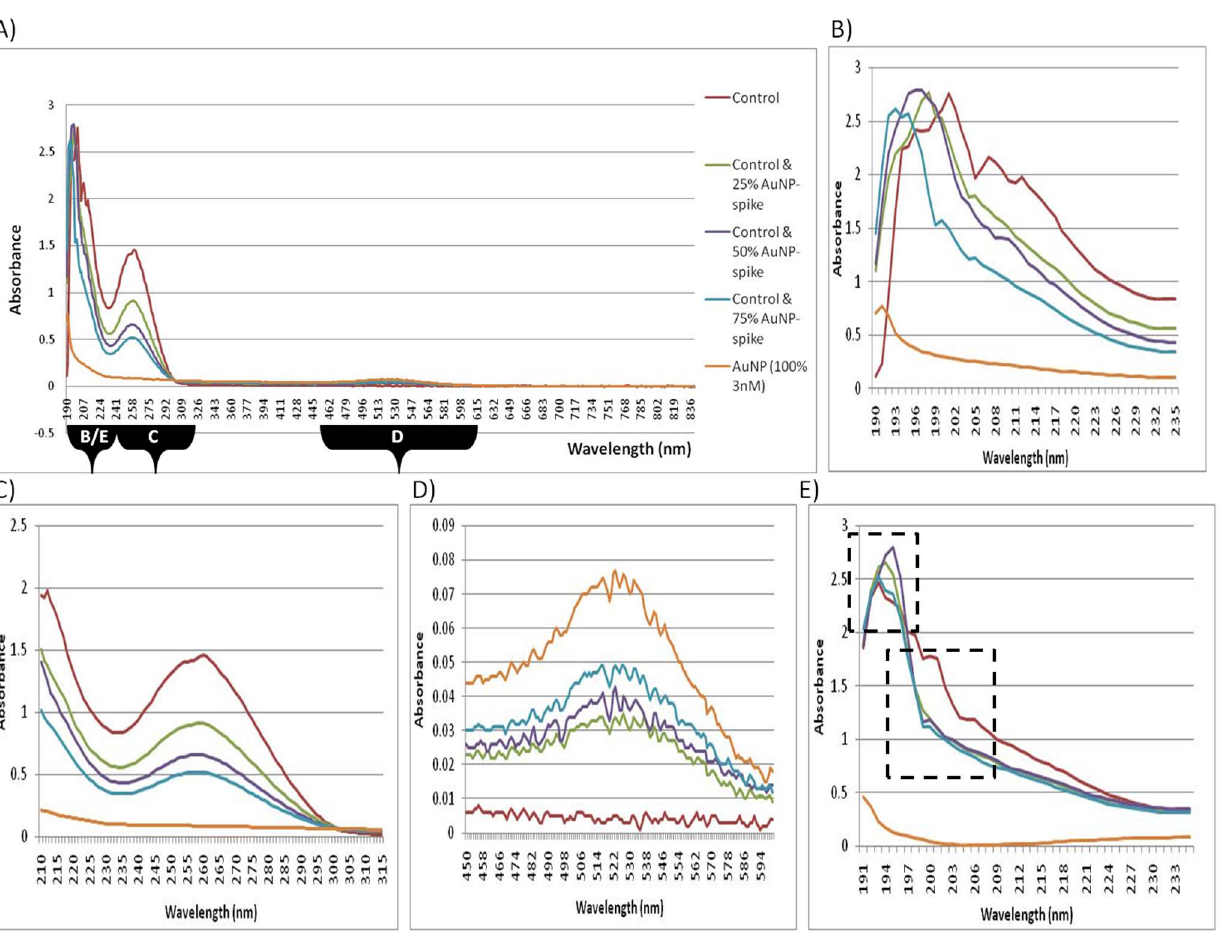
Figure 1. UV-Vis spectroscopy of RNA from post-isolation spiked samples. ( A ) Full spectrum absorbance analyses of artificial AuNP-spikes, measured at wavelengths from 190–840 nm. ( B ) Peak shifts of absorption spectra of artificial AuNP-spikes, measured at wavelengths from 190–235 nm. ( C ) Traditional absorbance spectrum analyses of artificial AuNP-spikes, measured at wavelengths from 220–340 nm. ( D ) Absorption spectra of artificial AuNP- spikes, measured at wavelengths from 450–600 nm. ( E ) Spiked samples containing a constant amount of RNA with variable percentage of AuNPs, indicating the absorption spectra measured at wavelengths from 190–235